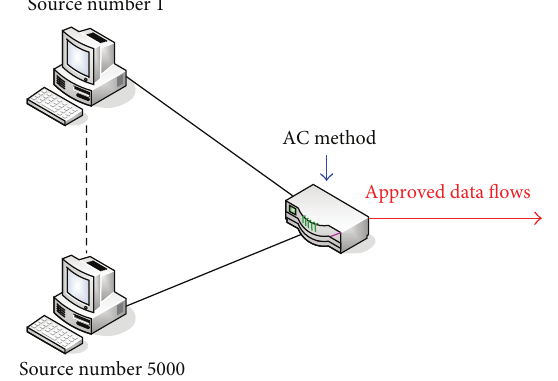
Figure 1: Simulated topology.